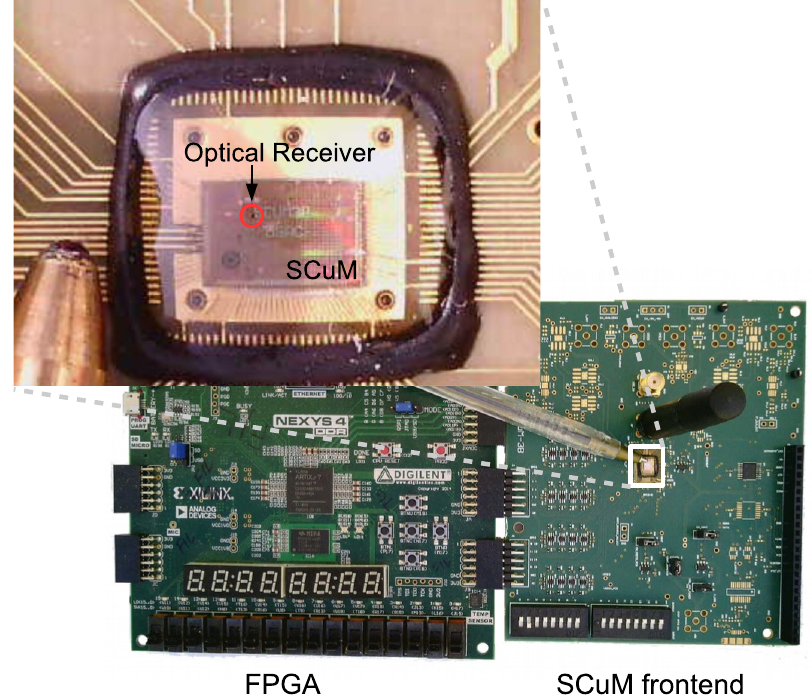
Figure 1. The Single Chip Micro-Mote (SCµM) is a 2 × 3 mm 2 mote-on-a-chip. It features an ARM Cortex-M0 micro-controller, an IEEE802.15.4 radio, and an optical bootloader. While SCµM runs with no